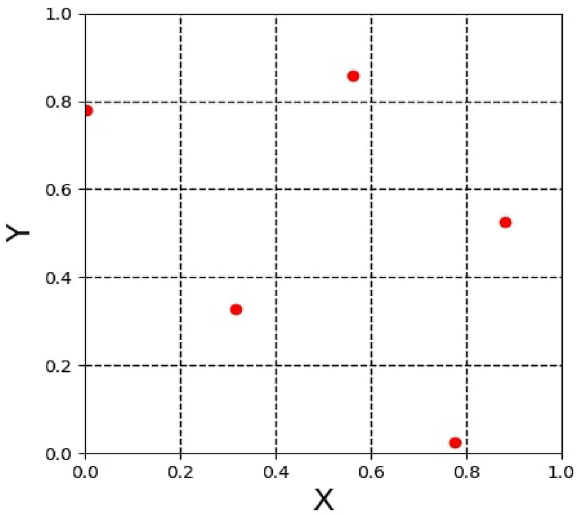
Fig. 2 Visualization of the Latin Hypercube Sampling for dimension n=2. In each row and each column exactly one sample is obtained